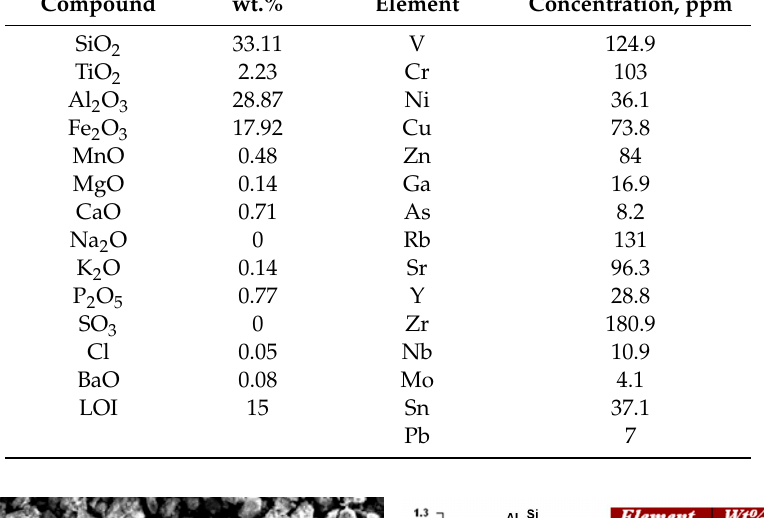
Table 6. Chemical composition and trace elements of halloysite determined by means of the X-ray fluorescence method.